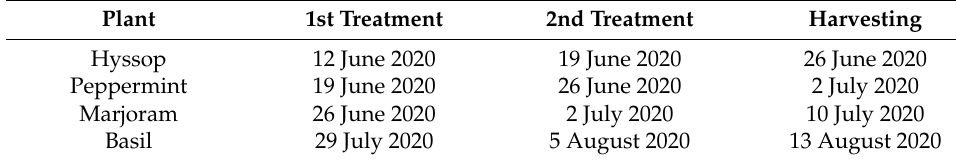
Table 3. Treatment and harvesting times of the experimental species.